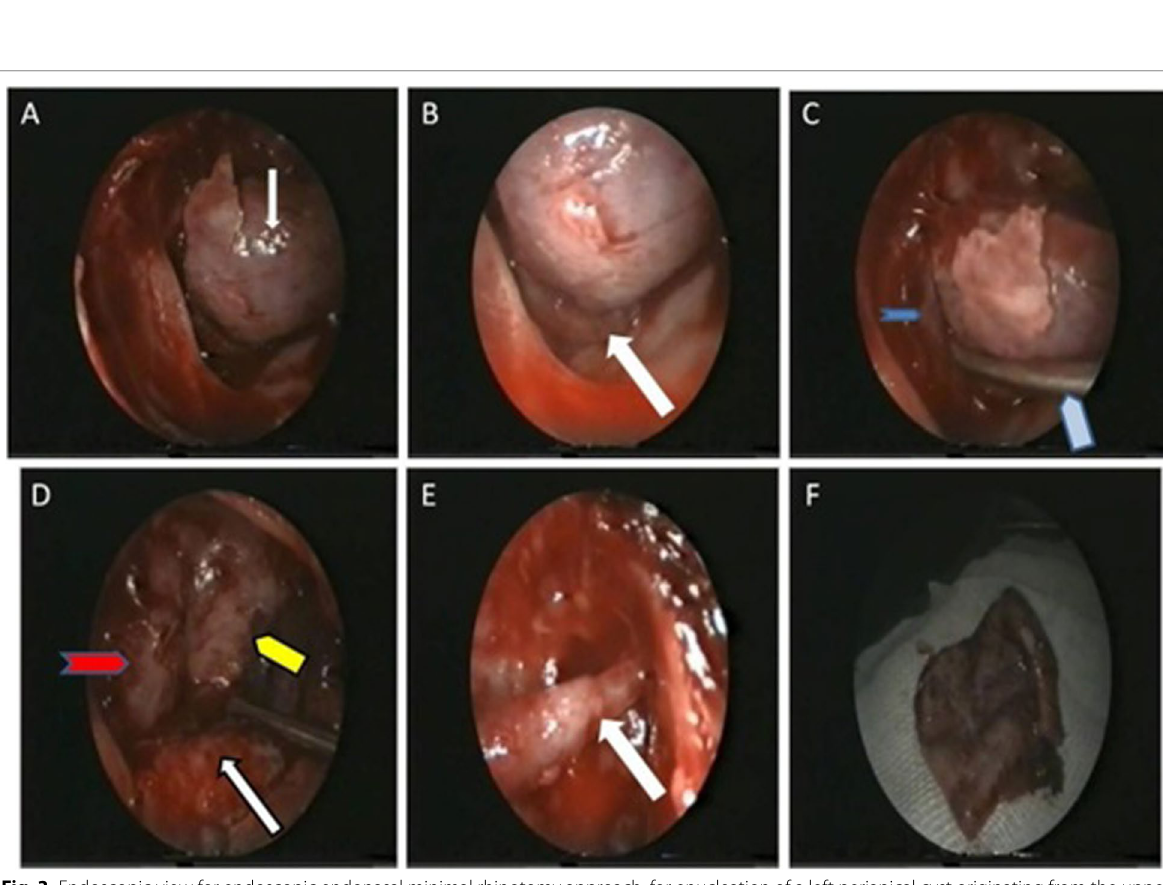
Fig. 3 Endoscopic view for endoscopic endonasal minimal rhinotomy approach: for enucleation of a left periapical cyst originating from the upper left canine. A The cyst wall (arrow) within its expanding cavity. B Dissection of the cyst wall (arrow) from part of the maxillary wall. C Dissection using a dissector (pentagon), elevating the cyst wall from the antral mucosa (chevron). D Complete dissection of the cyst (arrow) from the antral (chevron) and nasal (pentagon) mucosae. E Dissection of the cyst from the floor with a remaining attached pedicle that was cauterized. F The final cyst after